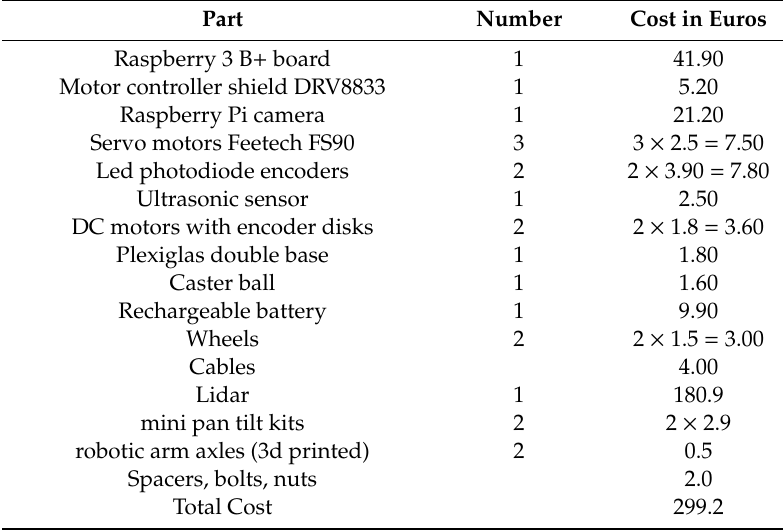
Table 2. List of EUROPA parts and approximate cost.